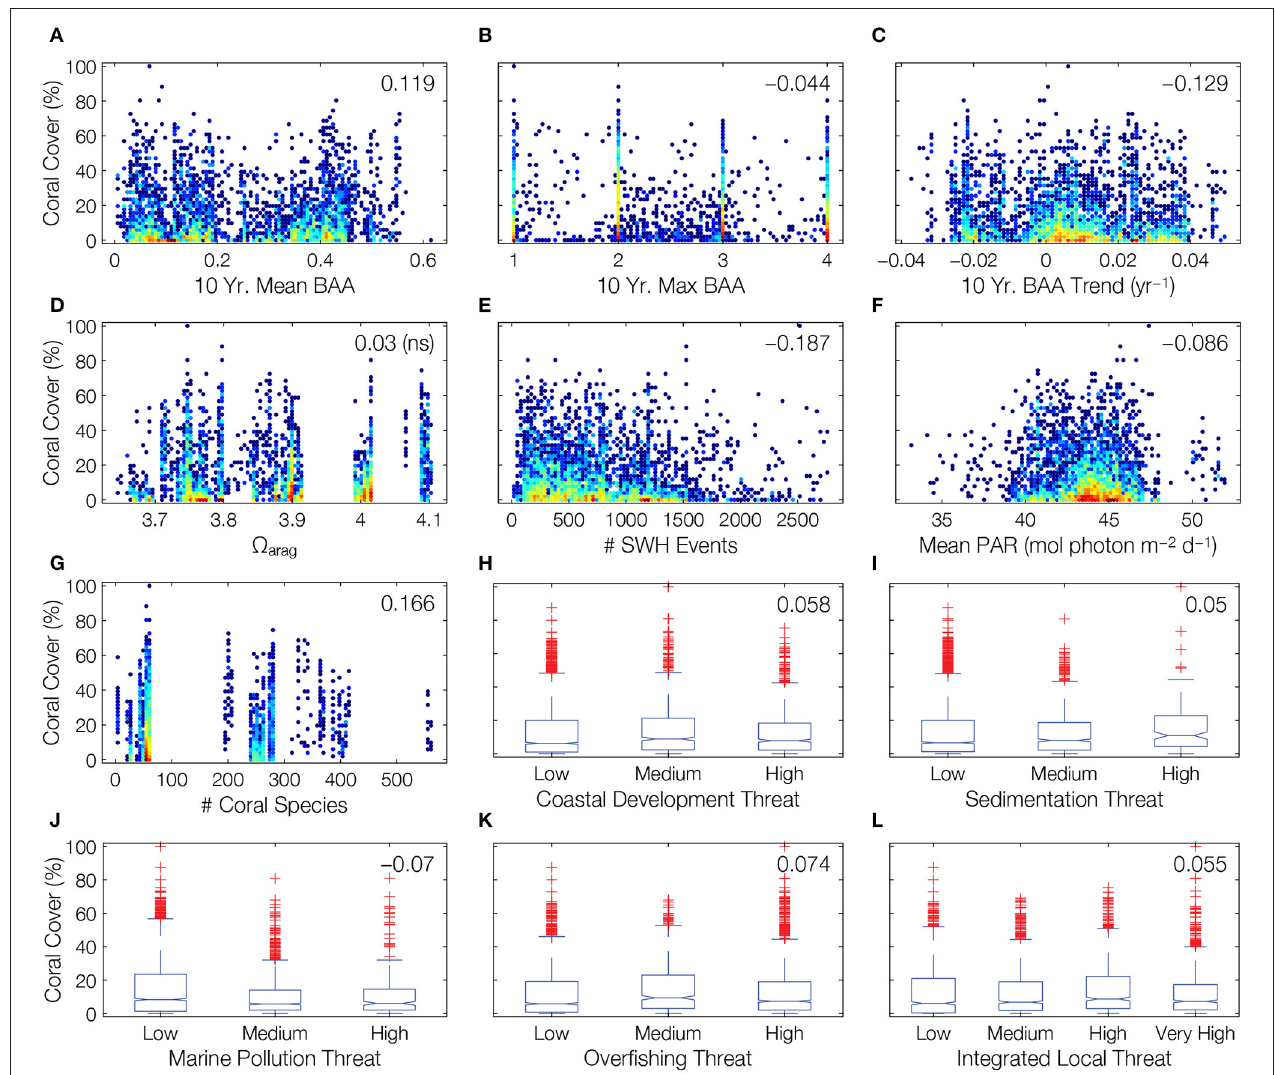
FIGURE 3 | Unexpected trends in the relationships between coral cover and biogeophysical forcings at the ecosystem scale. Gridded coral cover values are plotted against environmental factors, revealing trends contrary to prevailing scientific expectations. Scatterplots relate coral cover to continuous variables, with colors indicating point densities (blue is lower density, red is higher density). Boxplots show coral cover segmented by local anthropogenic threats, with first and third quartiles (blue box), median (red line), extent of data (black whiskers), and outliers (red plus symbols, determined using 1.5 × IQR rule). Numbers at top-right of all plots indicate Spearman rank correlation coefficients (ns = not statistically